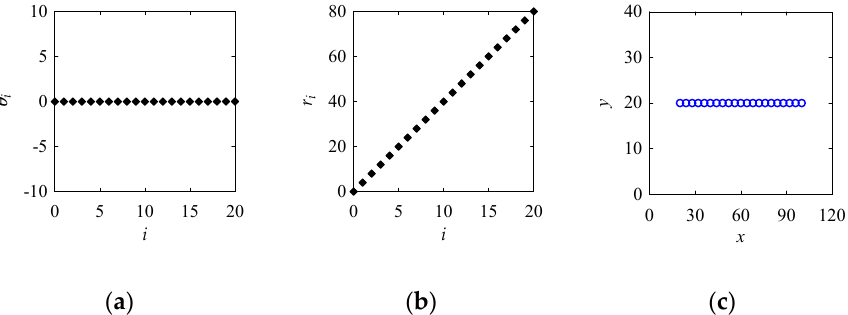
Figure 2. Settings for a horizontal straight line using the point cloud creation algorithm (PCA). ( a )